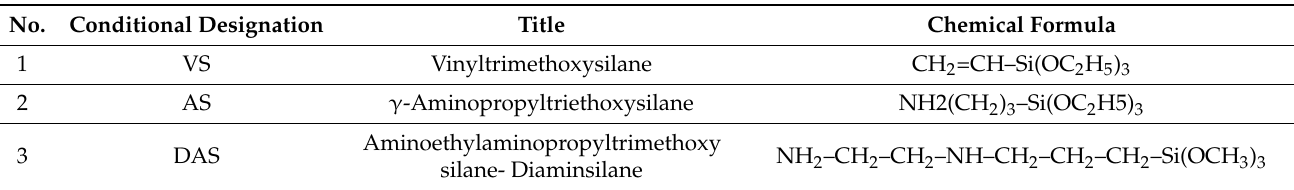
Table 1. Modifier compounds used on the surfaces of